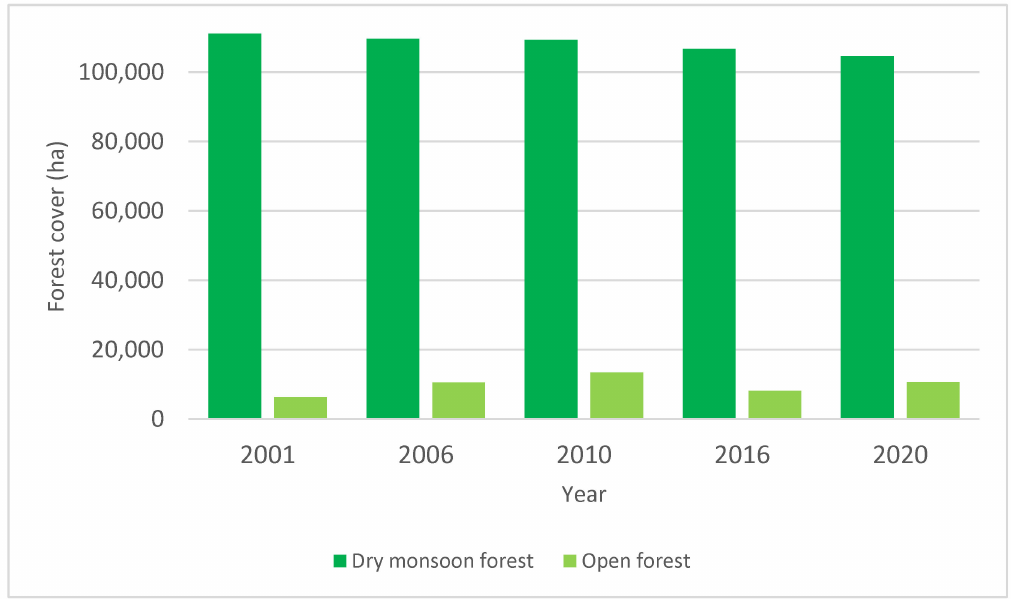
Figure 5. Dry monsoon and open forest cover changes between 2001 and